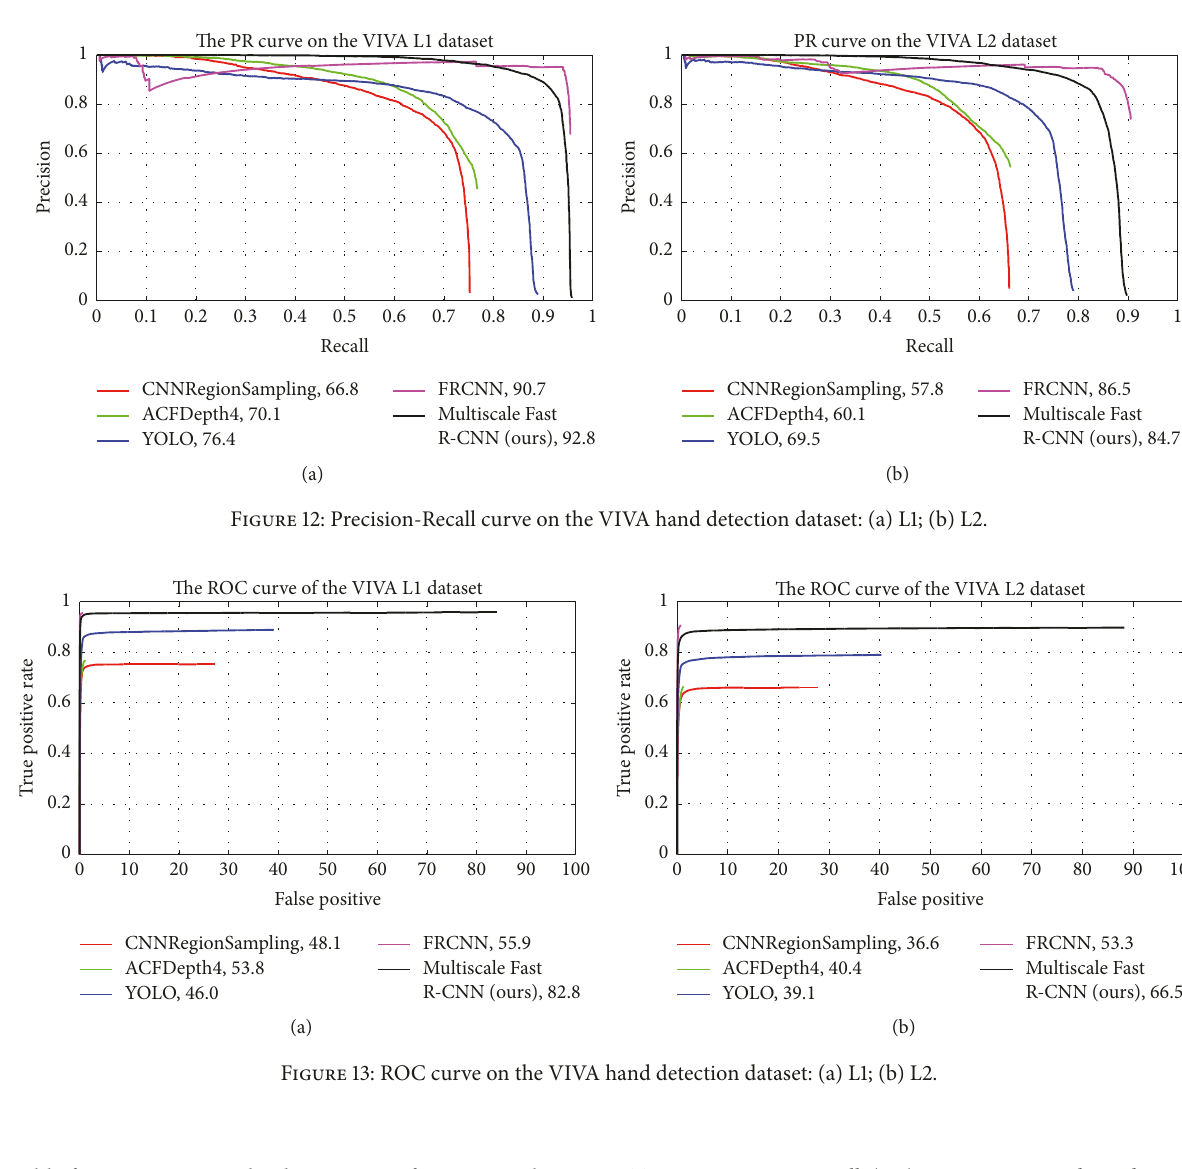
Table 4: Average Recall (AR) on VIVA L1 and L2 dataset and comparison with previous